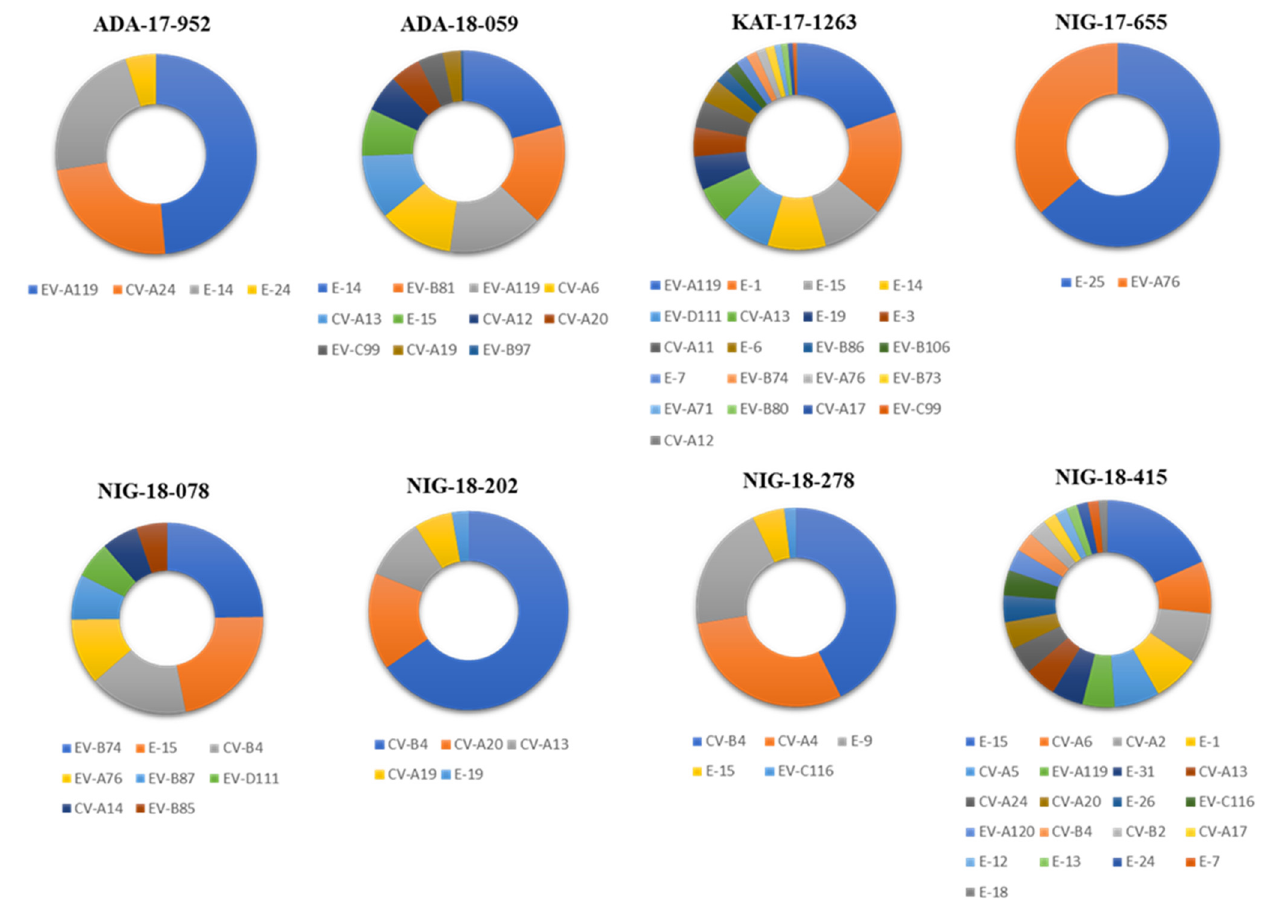
Figure 1. Enteroviruses (EV) serotypes identified in water samples from Nigeria. Filtered next generation sequencing (NGS) reads from RT-PCR products from the water concentrates were mapped to consensus sequences obtained for each sample. The proportions of reads mapping to each EV serotype in each sample are shown with different colors as indicated at the bottom of the figure.